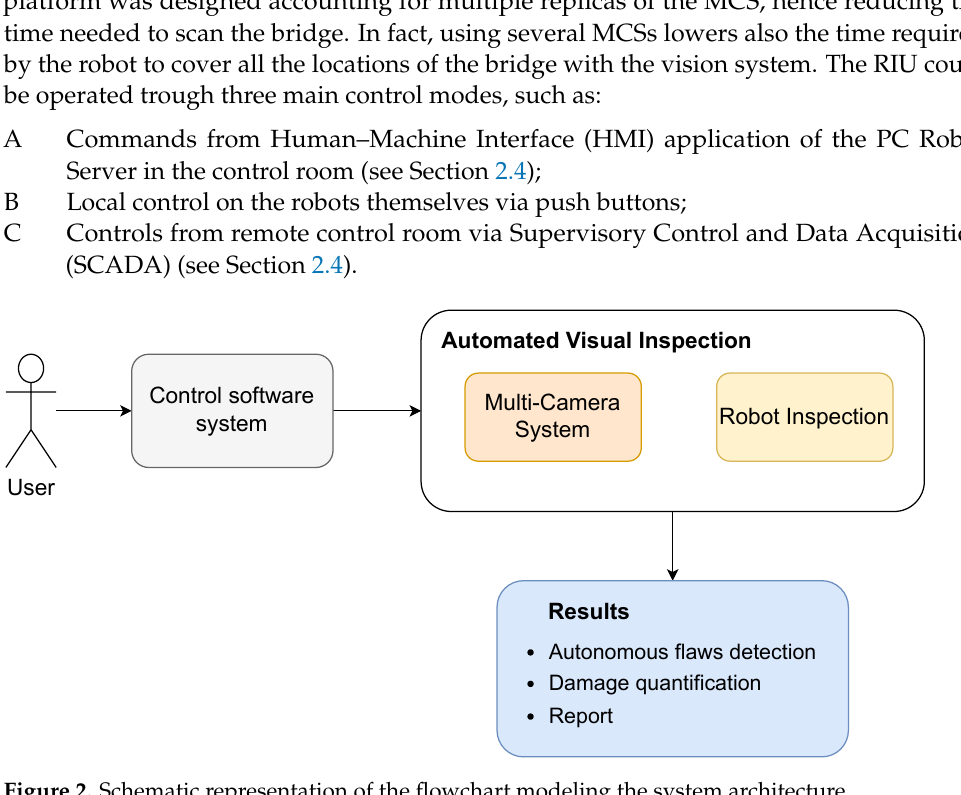
Figure 2. Schematic representation of the flowchart modeling the system